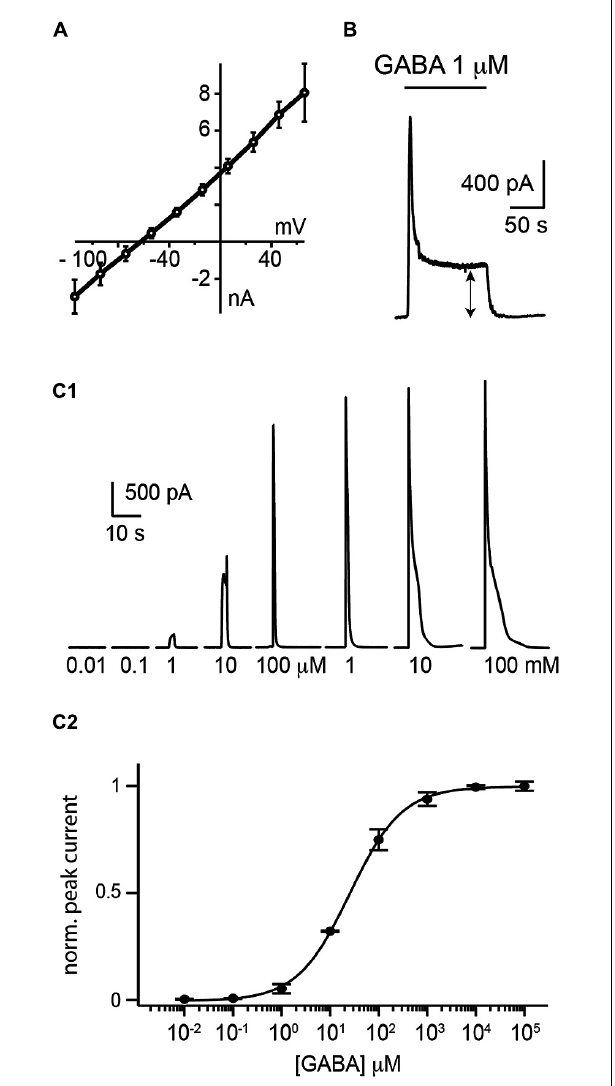
FIGURE 2 | Electrophysiological properties of the whole-cell sniffer. (A) I/V plot of sniffer responses to GABA (1 mM) from 7 cells clamped from − 120 to 80 mV.Values were corrected for liquid junction potential.The average reversal potential (E GABA ) was of − 67 mV. (B) Response of a sniffer to a prolonged exposure of GABA.The sniffer exhibited a non-inactivating component (double arrow). (C1) Responses of a sniffer to 1 s puff of increasing GABA concentrations (from 0.01 μ M to 100 mM). (C2) Hill plot of dose–responses relationships of peak currents ( r = 0.99994). Responses were normalized to the fitted I max value.The average EC 50 for the peak response was 26.3 ± 3.0 μ M (mean ± SE; n =